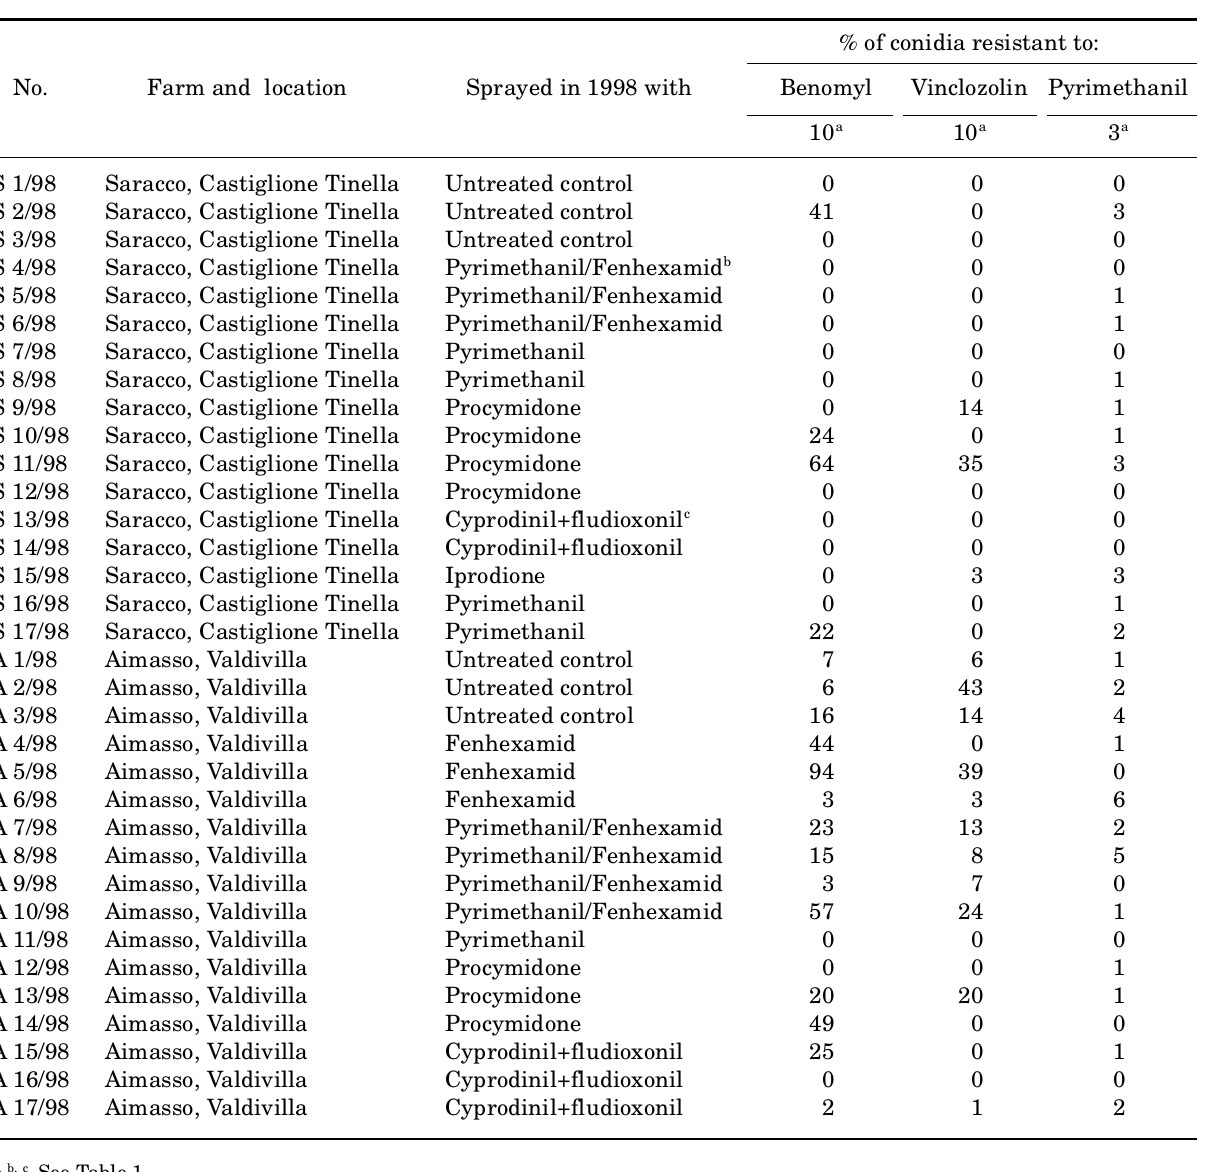
Table 2. Results of a survey in 1998, to detect resistance of Botrytis cinerea to different classes of botryticides in 2 vineyards (cv. Moscato) where experimental trials were carried out.